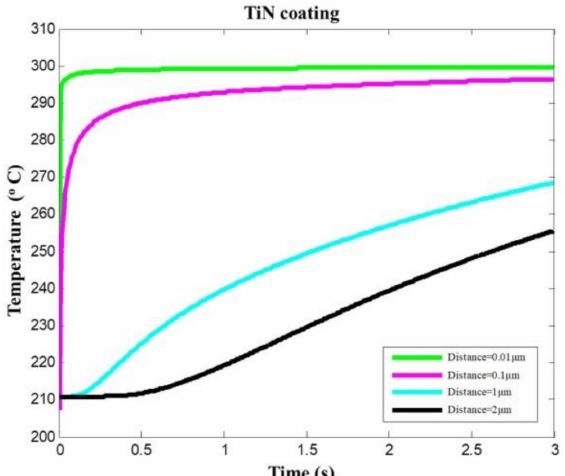
Figure 6. Temperature prediction at different locations within the TiN-coated tool coating.